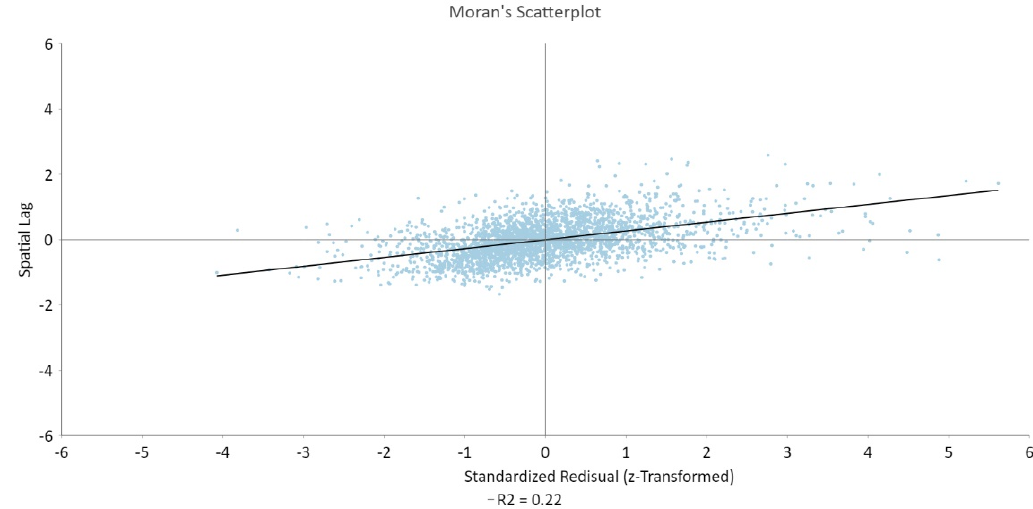
Figure 8. Scatterplot of the OLS standardized residuals.